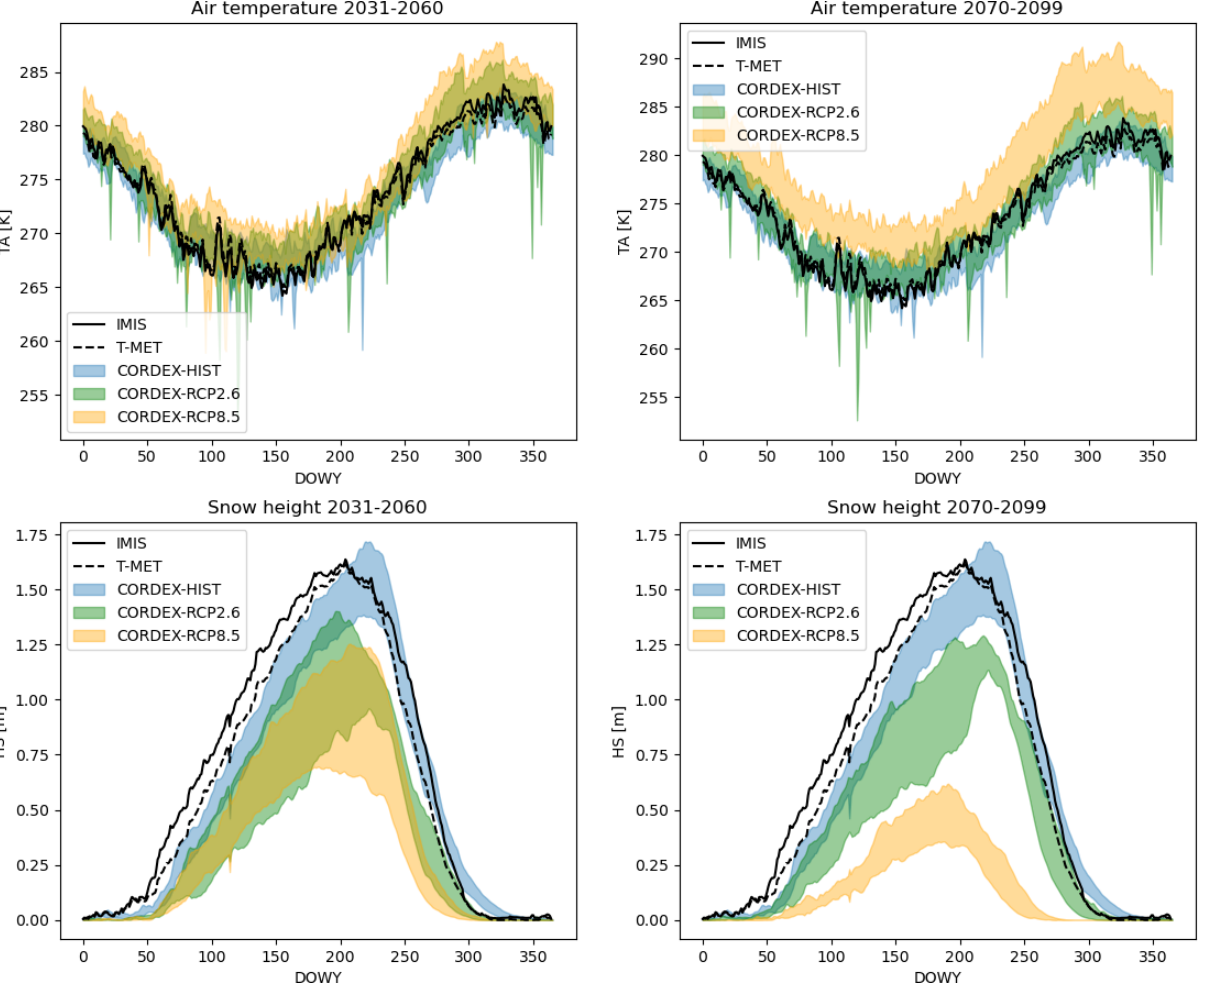
Figure 6. Large-scale evaluation of the scheme at all IMIS station locations. Network mean air temperature and snow depth across all IMIS stations (IMIS) are compared to the same data generated by the TopoSCALE downscaling of ERA5 (T-MET) and TopoCLIM-downscaled CORDEX data for the historical period (1981–2010) and scenarios RCP2.6 and RCP8.5 for near-future (2031–2060) and far-future (2070– 2099) periods for each day of water year (DOWY), starting at 1 September. The full width of the model ensemble is represented by the shading. Note that T-MET and IMIS have the same time frame (which varies by station between 1996 and 2020) and are therefore directly comparable (see Table 5), but this only partially overlaps with the CORDEX historical period and is therefore intended for visual comparison